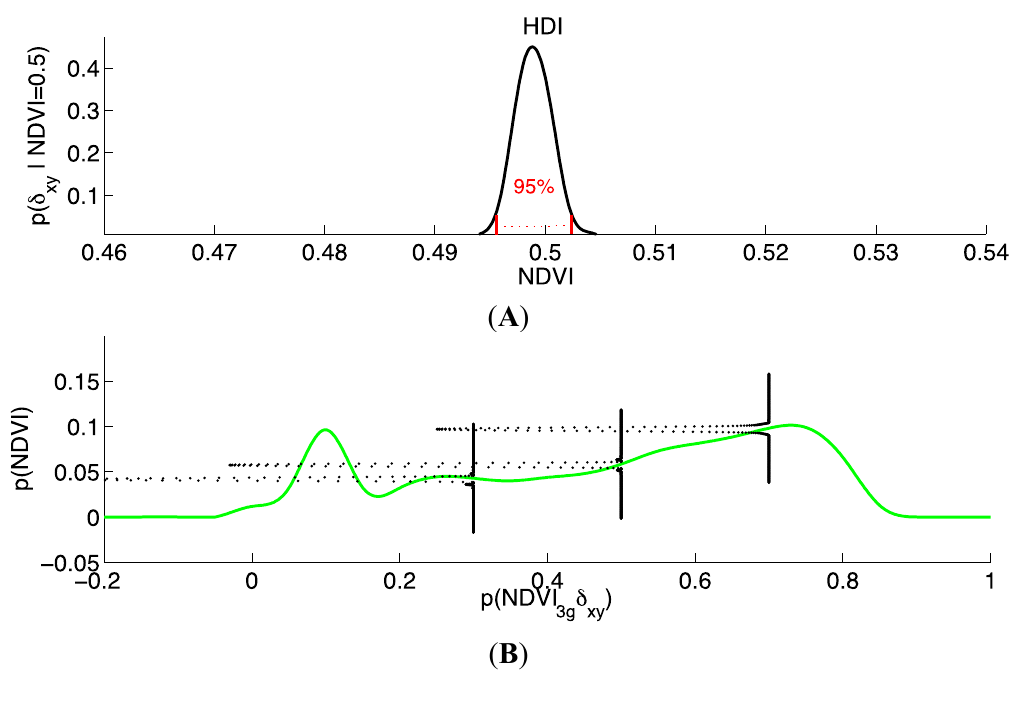
Figure 5. The top panel ( A ) shows an example of a 95% highest density interval (HDI) found from a fine grid approximating the probability density function, p (δ ( B ) NDVI data from the bottom panel’s NDVI value of 0.5. All the NDVI values inside 3g the highest density interval region, the red line in the top panel, have higher density than any other value outside the distribution envelope. The area under the curve through the highest density interval line comprises 95% of all the data. Every NDVI value within the effective NDVI dynamical range would have its corresponding p (δ 3g In the bottom panel (B), NDVI values are centered at 0.3, 0.5 and 0.7 of the NDVI probability distribution function, in green, and their respective highest density intervals are represented by the smaller dotted curves. The top panel (A) is an expansion of the 2nd distribution p (δ | NDVI = 0.5) and its respective highest density interval (−0.003, 0.002). xy The average width of all highest density intervals is 0.0036 giving an average uncertainty of ~ ±0.002 NDVI